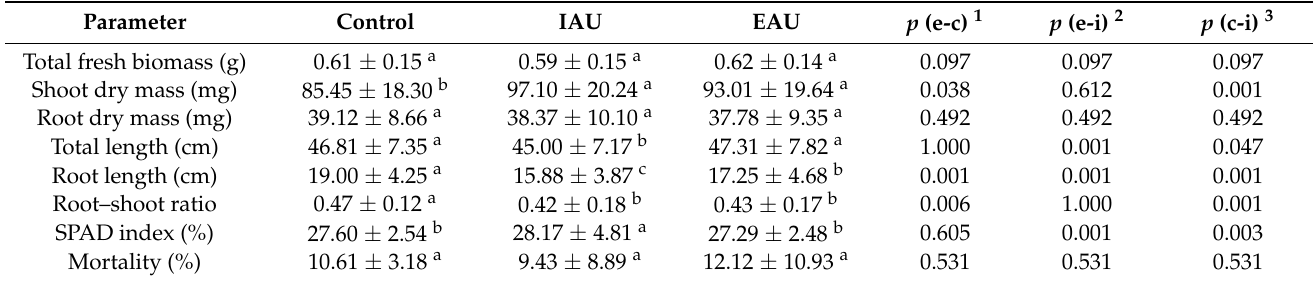
Table 5. Wheatgrass growth performance in the three different water irrigation groups without shoot and root fresh mass and shoot length, “Control”—fertilized tap water; “IAU”—fish effluents from intensive aquaculture unit; “EAU”—fish effluents from extensive aquaculture unit (mean ± SD, n = 3).